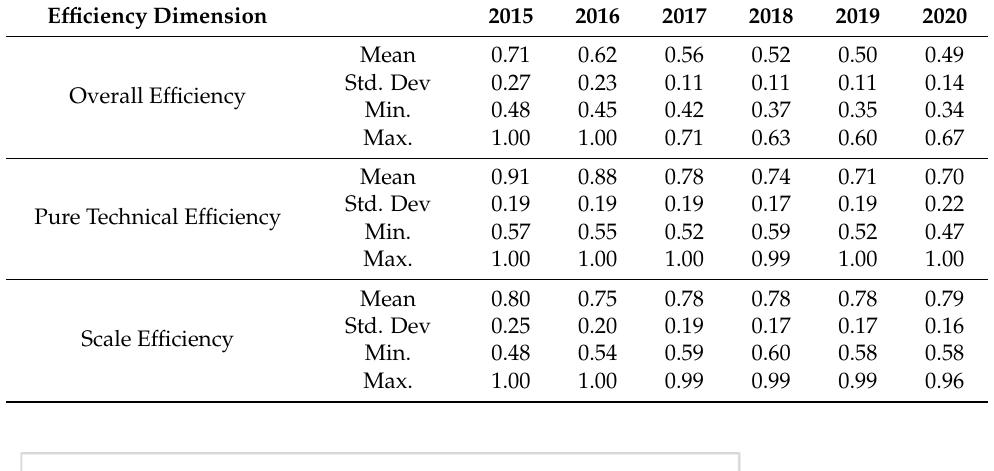
Table 2. Efficiency scores descriptive statistics.